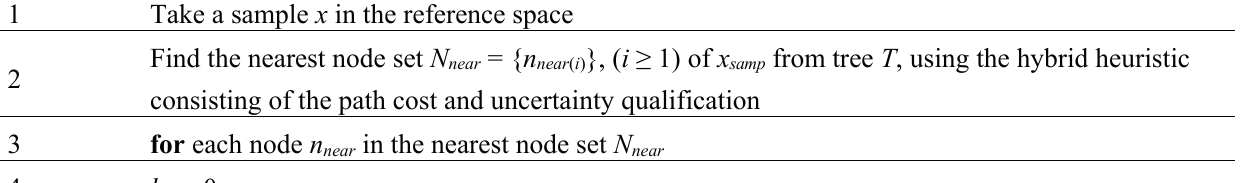
Algorithm 1. Closed-loop random belief tree: tree